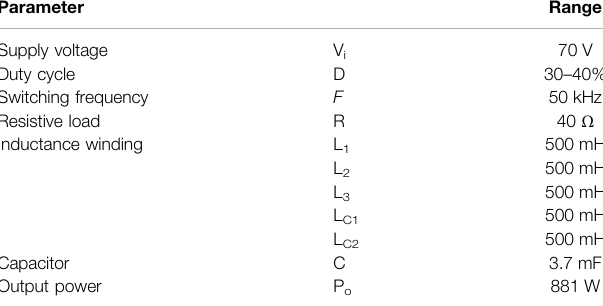
TABLE 2 | Ratings of the components involved in the proposed topology.